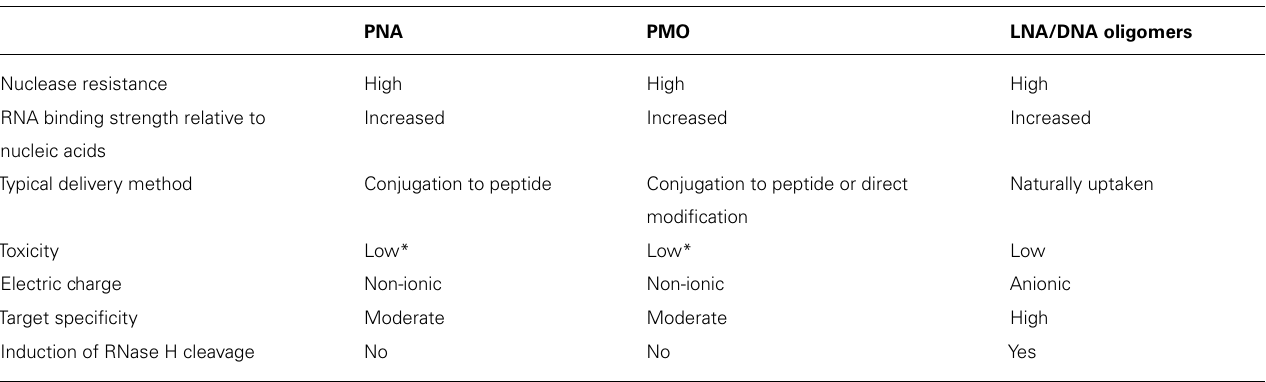
Table 1 | Comparison of different forms of synthetic nucleic acids used in therapeutic strategies that target bacterial RNAs. PNA PMO LNA/DNA oligomers Nuclease resistance High